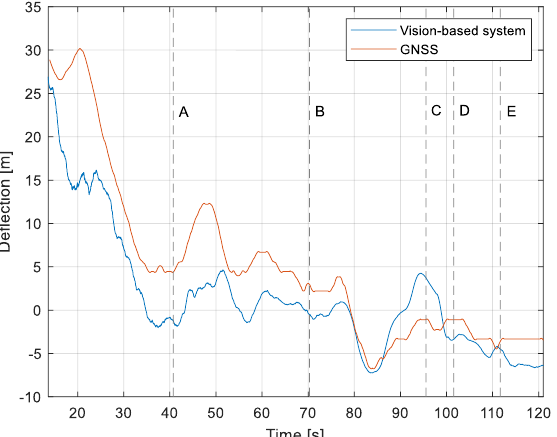
Figure 18. Linear lateral deflection from the center line: Flight no. 1 (markers A – E correspond to the moment of recording the images in Figure 9).